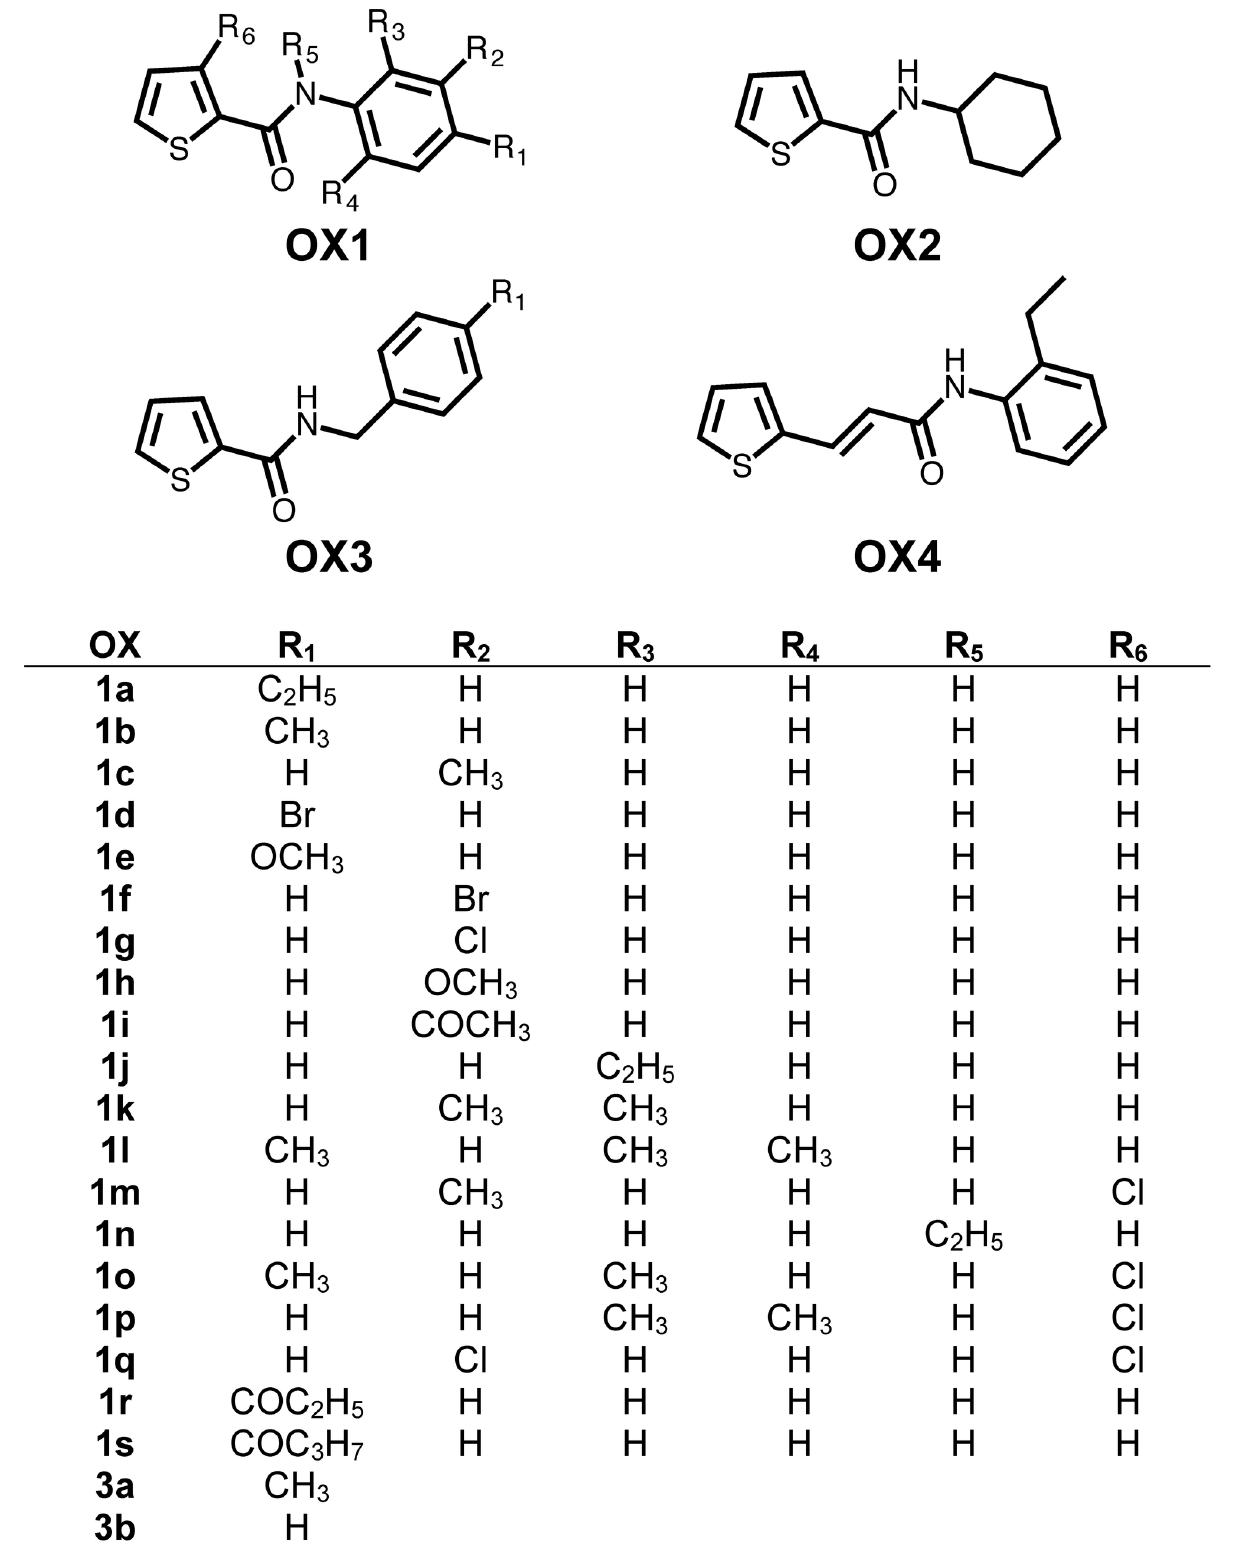
Figure 2. Compounds tested in this study.